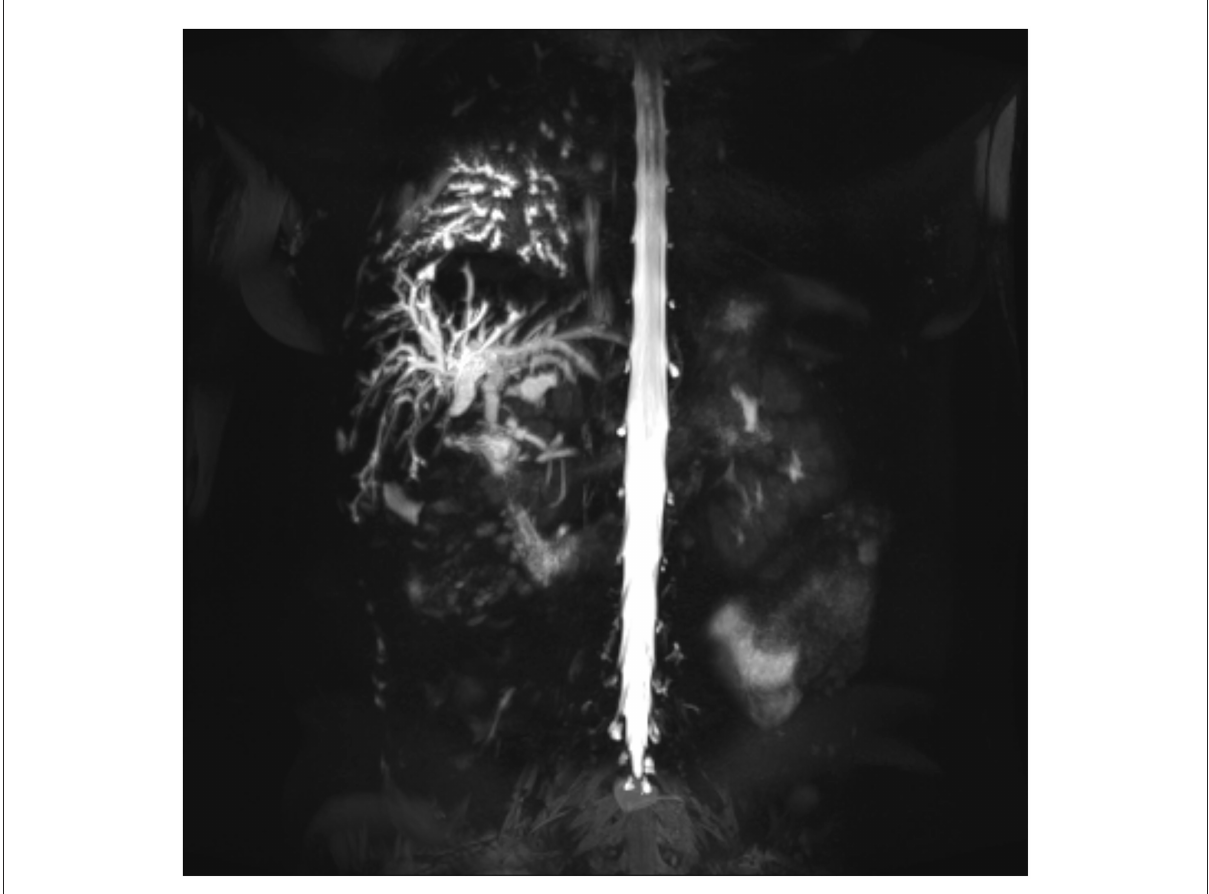
FIGURE3 Cholangiography—MRI showing the fistulous